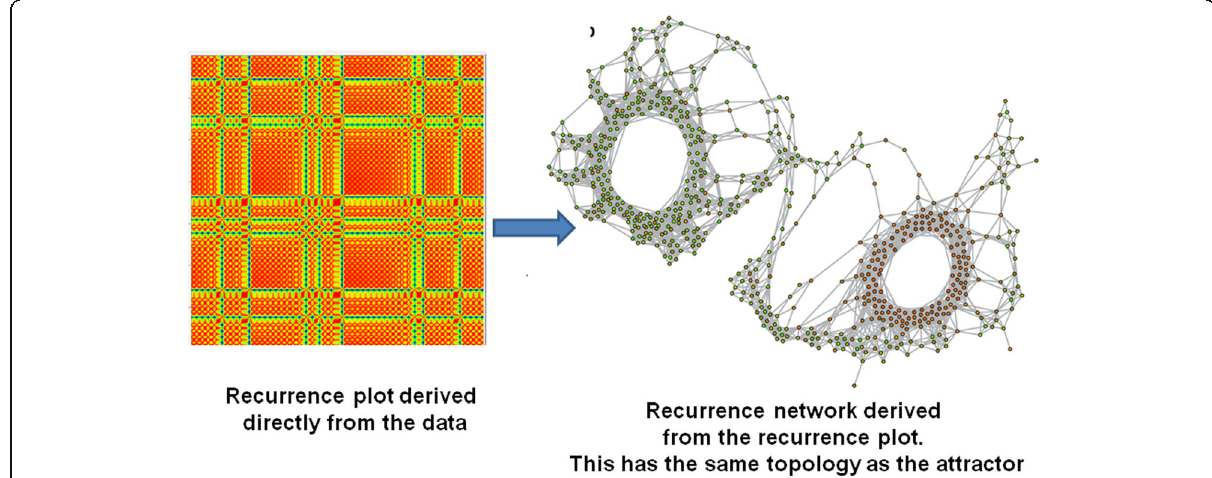
Fig. 8 Recurrence network for the Lorentz system. The recurrence network has the same topology as the attractor (Fig.